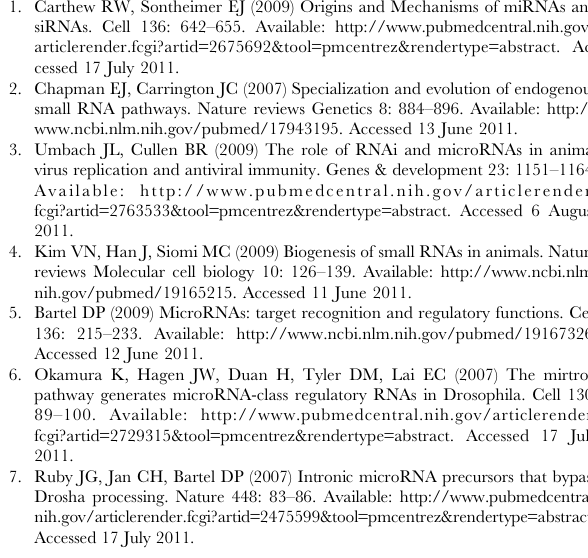
Table S5 A set of miRNA candidates identified in the mouse genome (build mm9). The columns of # reads represent the number of reads in all samples perfectly mapping to mature miRNA and hairpin sequences, respectively. The column of location indicates the names of host genes overlapping with miRNAs. Table S6 Conservation of noncanonical miRNAs and endo-siRNAs that were analyzed. (XLSX) Table S7 MHV68 open reading frames targeted by MHV68 virus miRNAs. The number at the end of the miRNA name represents the digital counts of the miRNA and indicates the corresponding isoform. Annotation of MHV68 open reading frame can be downloaded from NCBI with accession number NC_001826.2. Table S8 List of genes in mouse genome targeted by MHV68 virus miRNAs. Table S9 List of genes in mouse genome targeted by the differentially expressed murine miRNA (miR-142-3p). Table S10 Representative Gene Ontology functions of predicted genes targeted by virus and differentially expressed